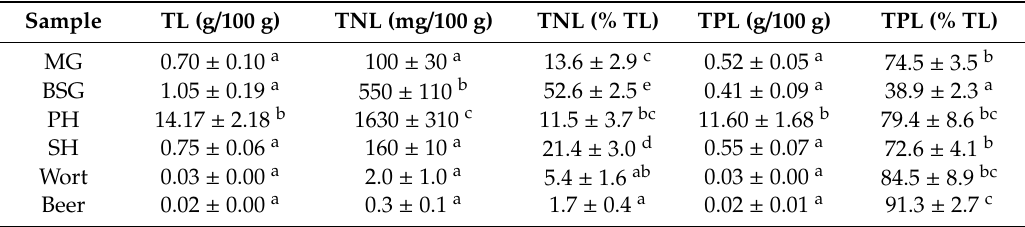
Table 1. The total lipid (TL) and the total polar lipids (TPL) content of beer and brewing by-product are expressed as g / 100 g and the total neutral lipid content (TNL) is expressed as mg / 100 g. The TPL and TNL are also expressed as a percentage of the TL (mean ± SD, n =